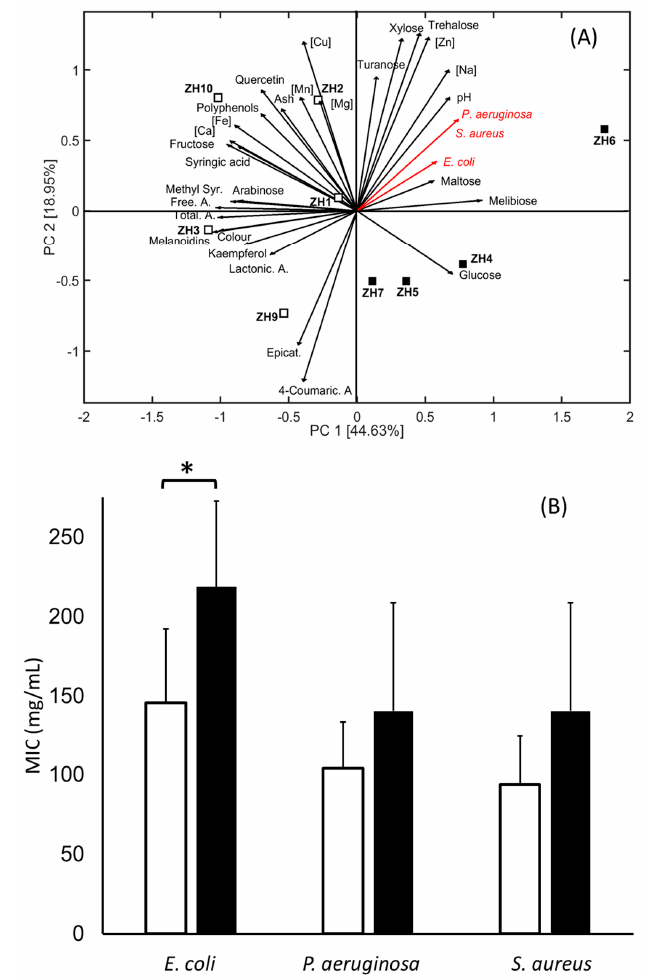
Figure 4. ( A ) PCA of Zantaz honey samples using the most discriminating parameters and MIC antibacterial activity (red arrows). ( B ) Average MIC of the groups with the lowest (full bars) and highest (open bars) antibacterial activity. * p < 0.05.